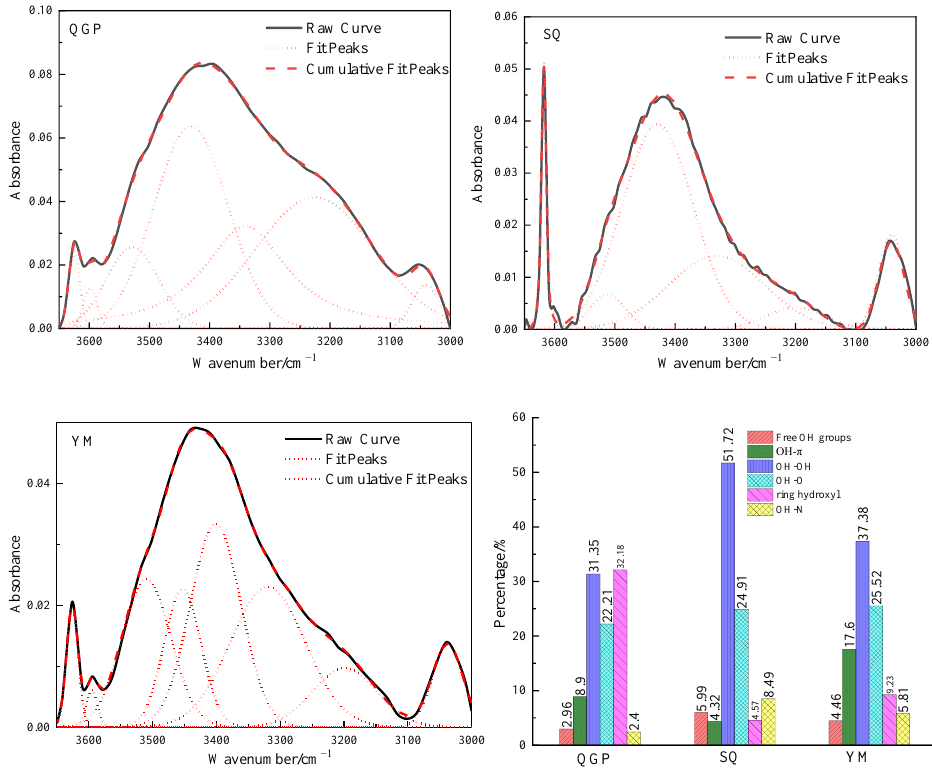
Figure 5. Fitting results and occurrence content of hydroxyl in coal samples.